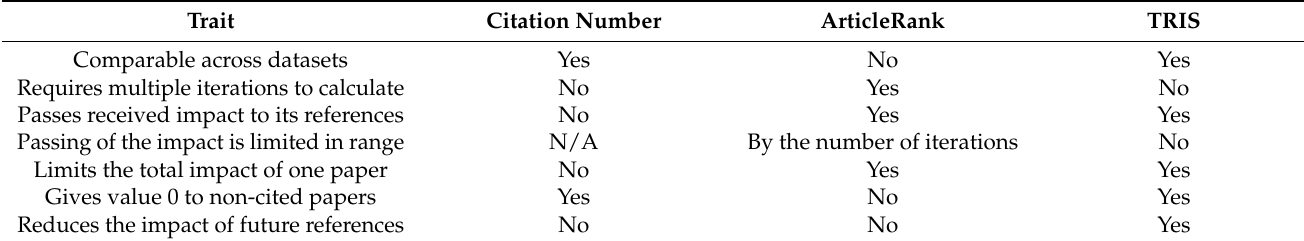
Table 1. Comparison of the key traits of Citation Number, ArticleRank, and